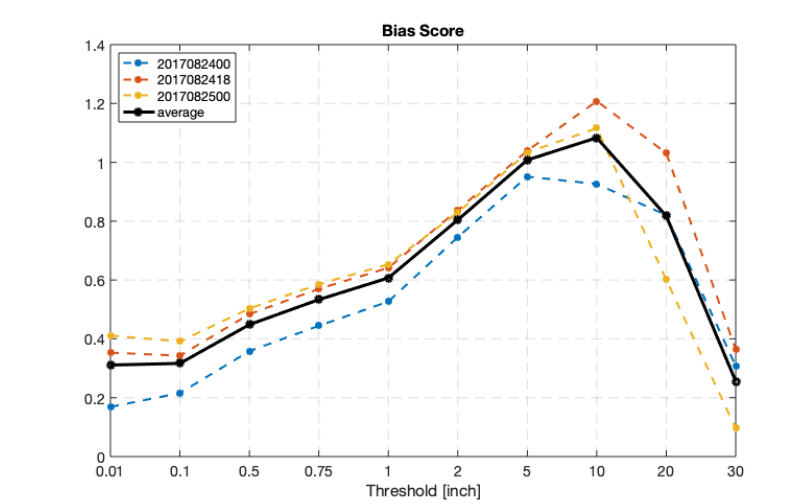
Figure 6. Similar to Figure 5 but for bias